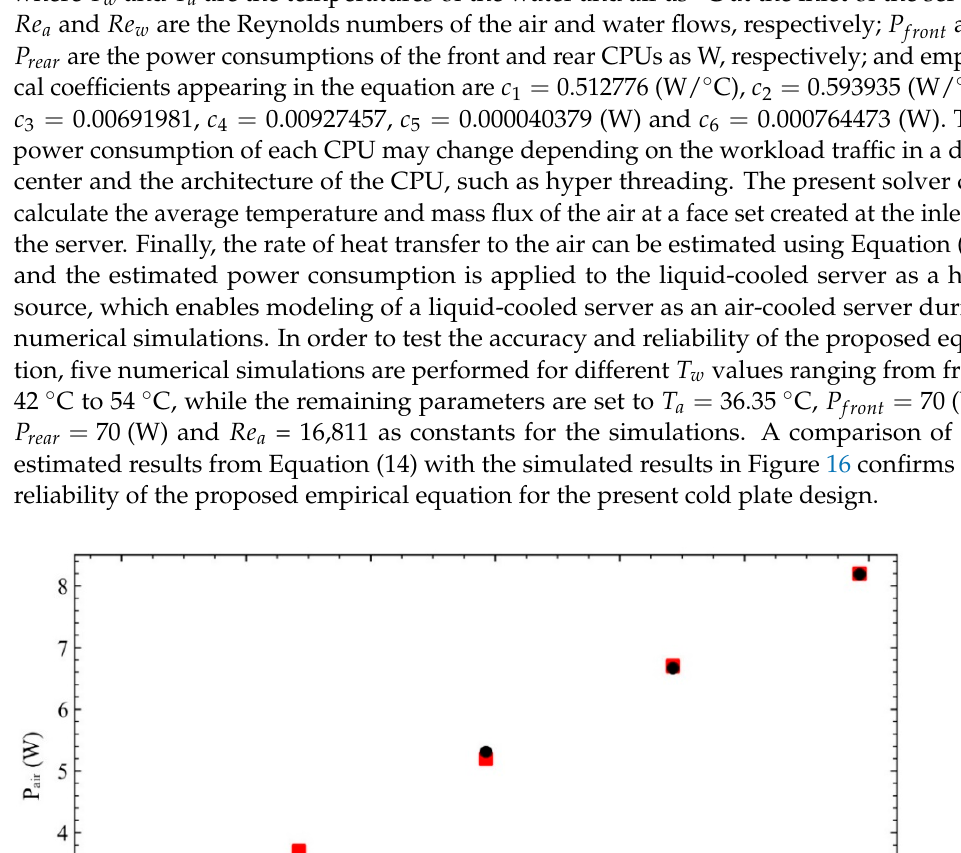
Figure 17. Three-dimensional views of ( a ) computational domain with boundaries and ( b ) server cabinet.